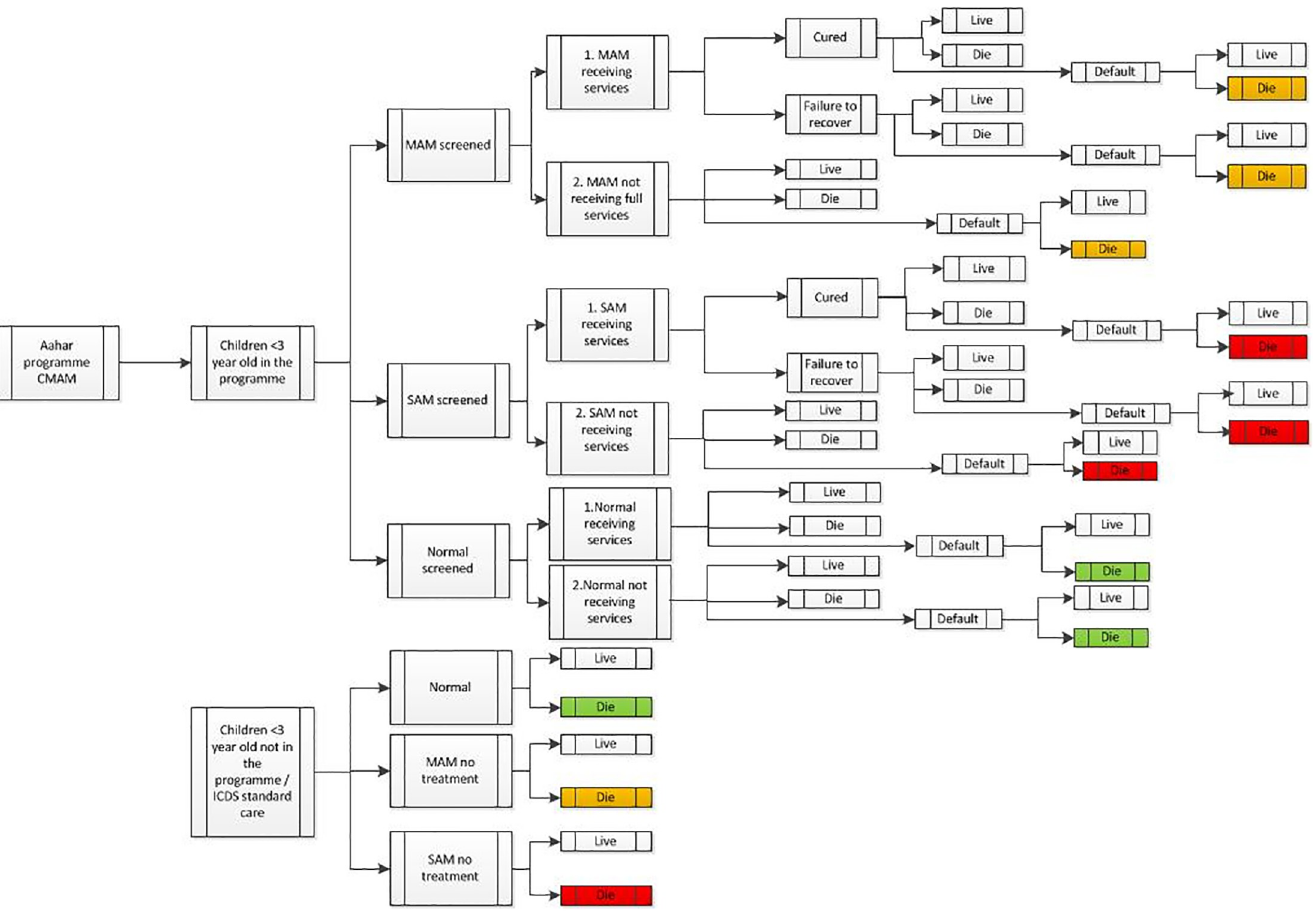
Fig 1. Decision tree CMAM and prevention for Aahar acute malnutrition programme. Cured, SAM: Improved to MAM or normal (Weight-for-Height z > -3 SD (WHO 2006 growth references) for at least 1 month over the 1 year period extended by the 3 following months as change in nutritional status may be delayed) Cured, MAM : Improved to normal (Weight-for-Height z > -2 SD for at least 1 month within 12 months extended by the 3 following months as change in nutritional status may be delayed) Failure to recover, SAM : Remained SAM. Failure to recover, MAM : Moved from MAM to SAM, or remained MAM over the 1 year period. Failure to recover, Normal : Moved from normal to MAM or SAM over the 1 year period. Default, SAM, MAM or Normal : Turned 3 years old, migrated, or was screened incorrectly. Relapse, SAM : Recovered but relapsed to SAM over the 1 year period. Live, Children in the programme (SAM, MAM or normal): Based on programme data Live, Children not in the programme (SAM no treatment, MAM no treatment or normal): Based on data from survey data.